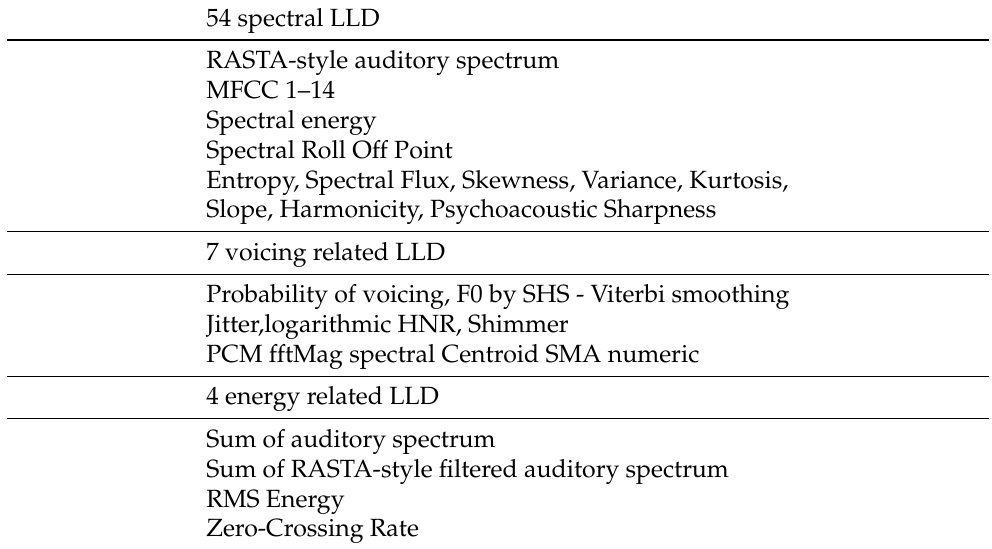
Table 1. 65 provided Low-Level Descriptors (LLD).